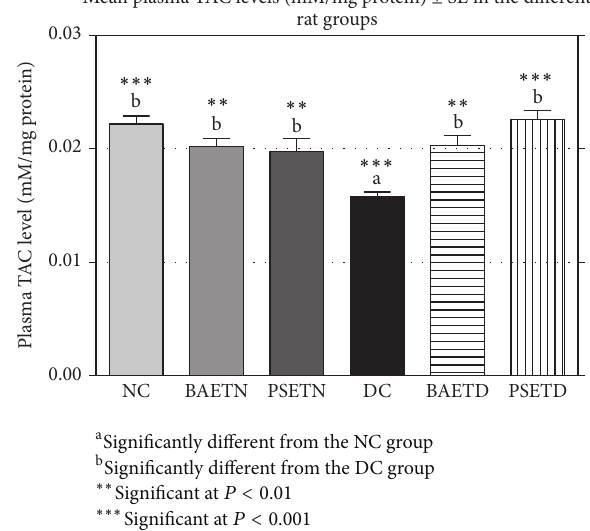
Figure 5: Oral administration of either Balanites aegyptiaca fruit aqueous extract or Petroselinum sativum leaf aqueous extracts to the diabeticratsproducedasignificant( 𝑃 < 0.01 )increaseintheirmean plasma TAC levels when compared with the diabetic control